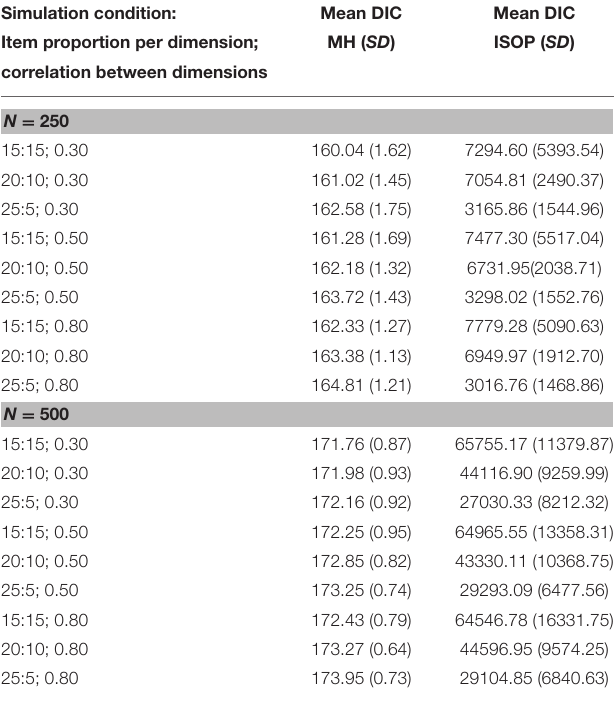
TABLE 1 | Mean and (Standard Deviations) of the DIC statistic under different conditions of multidimensionality for the MH and ISOP model.